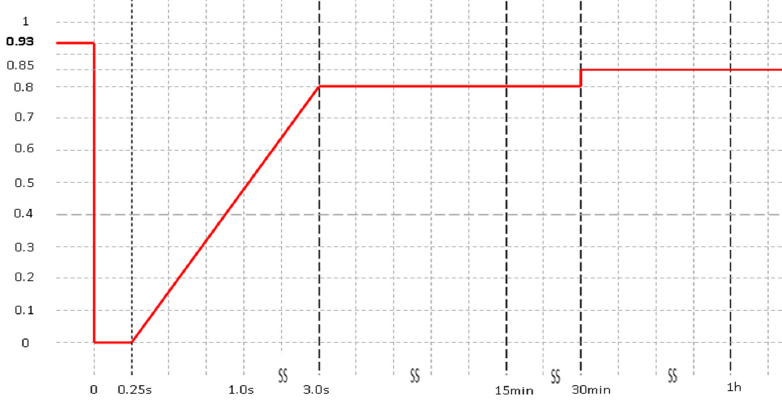
Figure 27. The typical limit curve for IEEE 1547 LVRT requirements.